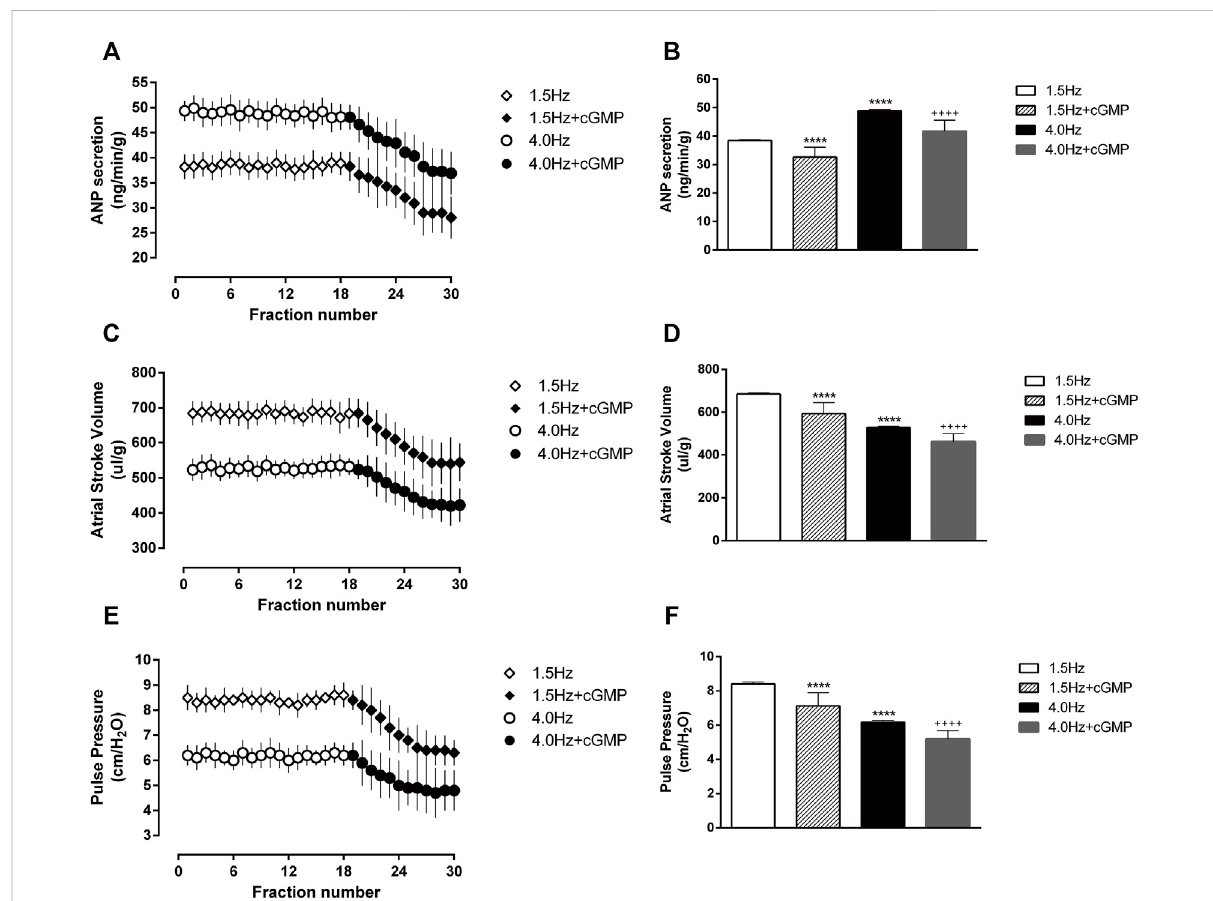
FIGURE 8 Effectsofhigh-frequencystimulationonANPsecretionandatrialdynamicsinisolatedatrialperfusion. (A) Effectsofhigh-frequencystimulation and cGMP on atrial ANP secretion. (B) Quantitative analysis of the effects of high-frequency stimulation and cGMP on atrial ANP secretion. **** p < 0.0001 vs. 1.5 Hz; ++++ p < 0.0001 vs. 4.0 Hz. (C) Effects of high-frequency stimulation and cGMP on atrial stroke volume. (D) Quantitative analysis of the effects of high-frequency stimulation and cGMP on atrial stroke volume, **** p < 0.0001 vs. 1.5 Hz; ++++ p < 0.0001 vs. 4.0 Hz. (E) Effects of high-frequency stimulation and cGMP on atrial pulse pressure. (F) Quantitative analysis of the effects of high-frequency stimulation and cGMP on atrial pulse pressure, **** p < 0.0001 vs. 1.5 Hz; ++++ p < 0.0001 vs. 4.0 Hz. Data are expressed as means ± SEMs, n =